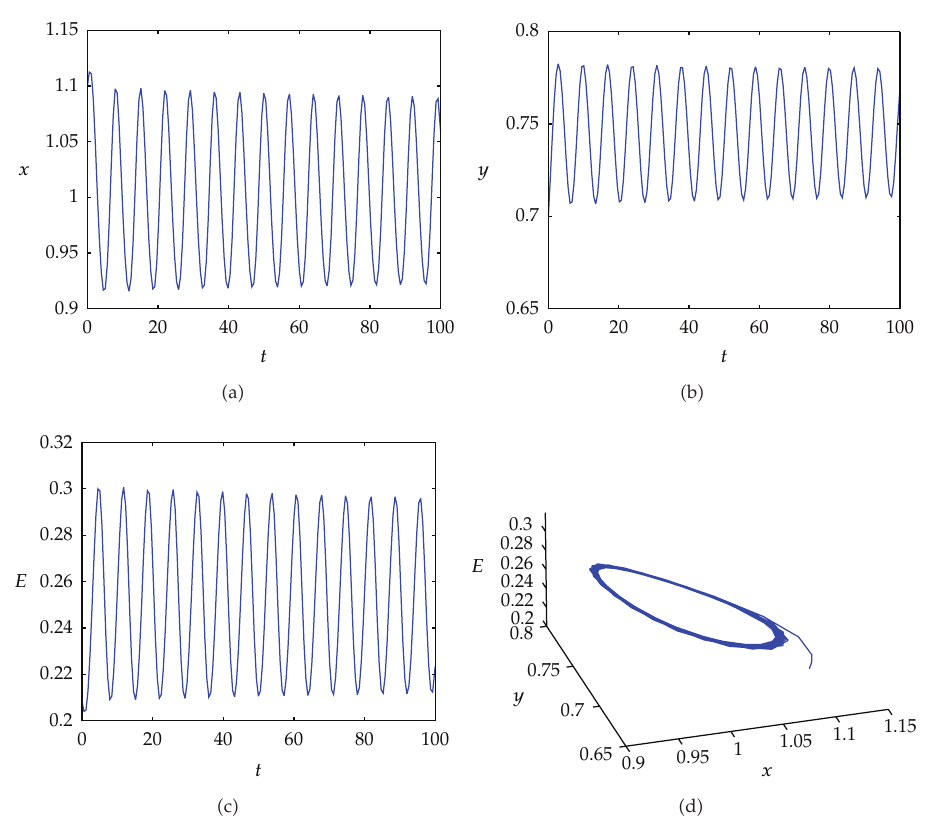
Figure 2: When τ (cid:5) 0 . 5618, periodic solutions occur from Y 0